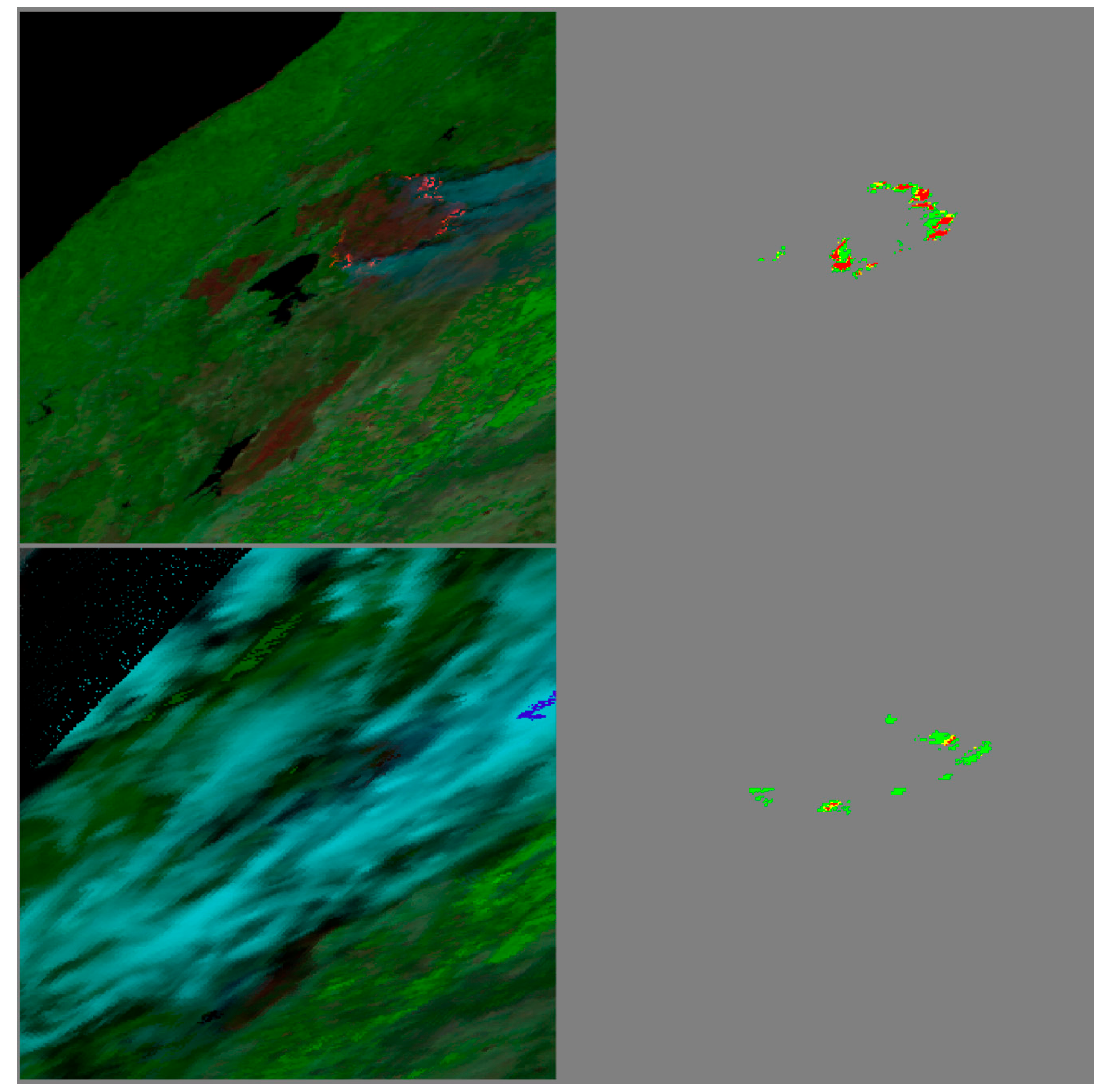
Figure 5. Proof of concept results for the Ranch fire 150 km × 150 km subset centered on N 39.03, W 122.78 on 4 August 2018, DOY 216 ( top ) and 5 August 2018, DOY 217 ( bottom ). Left images are false color composite using red (2.13 μ m), green (0.85 μ m), and blue (0.64 μ m) reflectance bands. Under clear skies ( top ), the downscaling algorithm assigns the high and moderate probabilities (red and yellow respectively) to pixels with obvious flaming fronts (right image). The algorithm is less useful if the active fires are obscured by smoke and or clouds and most pixels are assigned with a homogenous low probability (green) ( bottom left image).